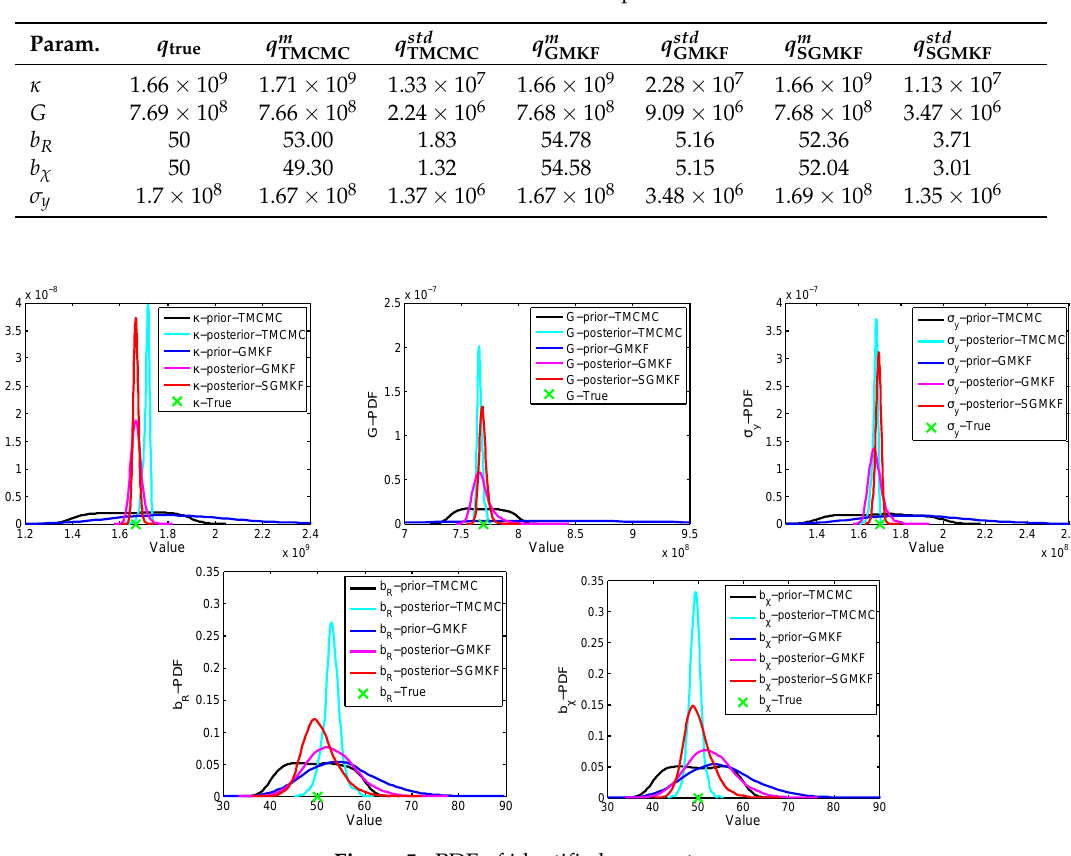
Table 3. The identified model parameters.